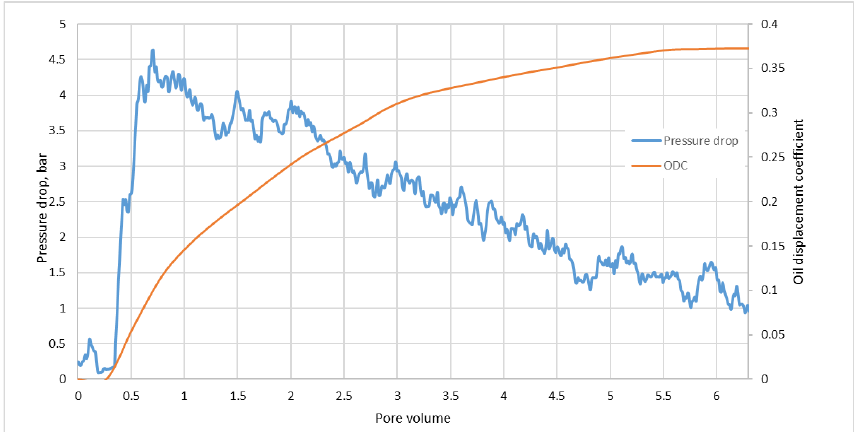
Figure 2. Pressure drop and oil displacement coefficient in experiment № 2. After pumping 0.5 PV, there was a sharp increase in pressure drop to 6 bar. With further injection of steam, the pressure drop in the model decreases to 1 bar. The largest oil displacement corresponds to the interval 0.3 – 3.0 PV. During the experiment, 55.9 g of oil was displaced, the displacement coefficient of 37.2% was achieved. Results of filtration experiment № 3. Steam injection with solvent and catalyst addition at 300 °С .